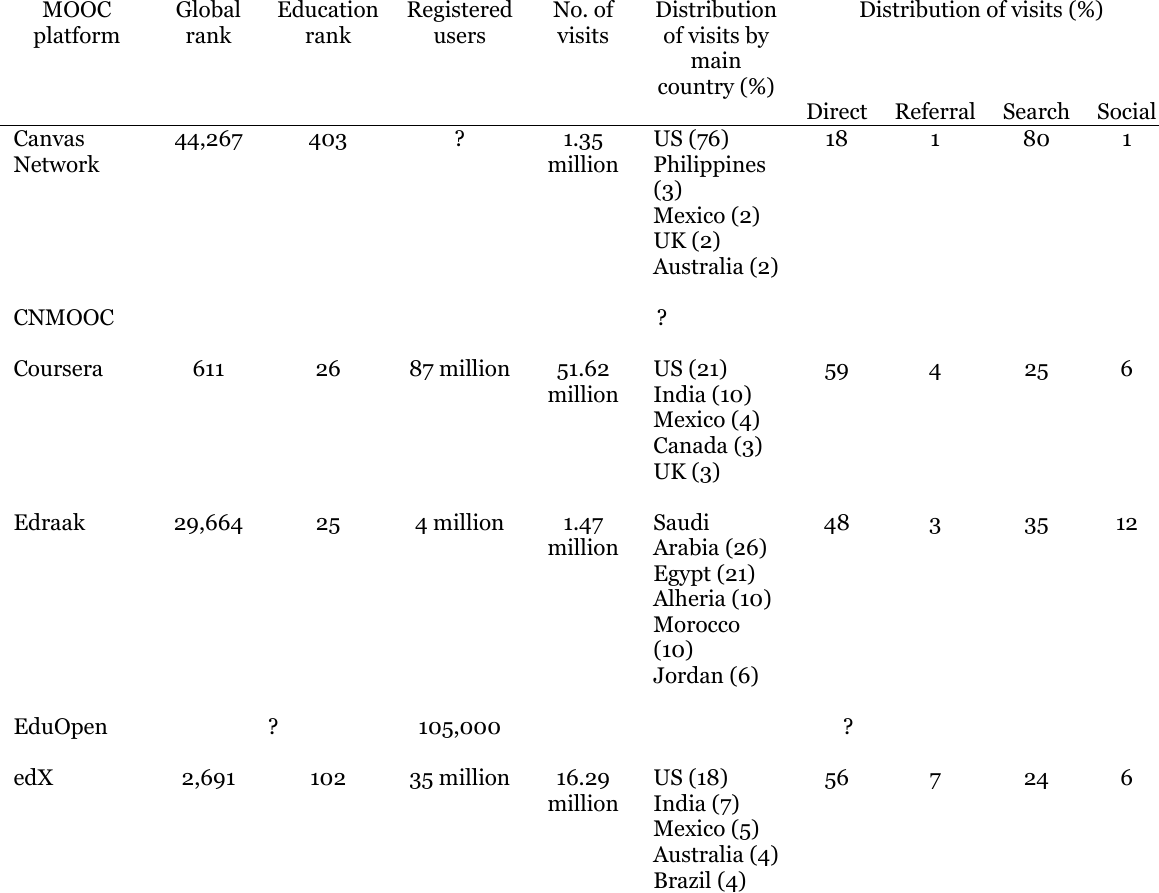
MOOC Platform s’ Popularity: SimilarWeb Rankings and Data on Visitors and